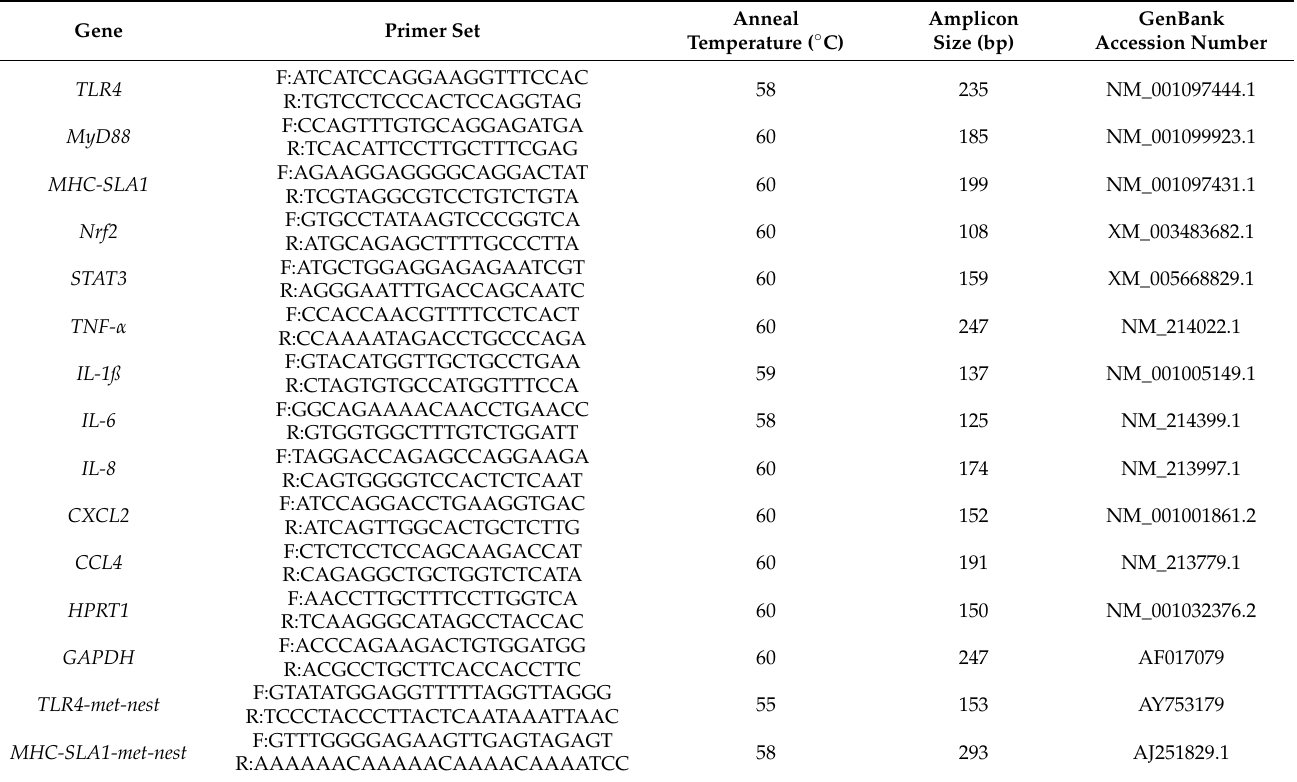
Table 1. List of primer sequences used in this